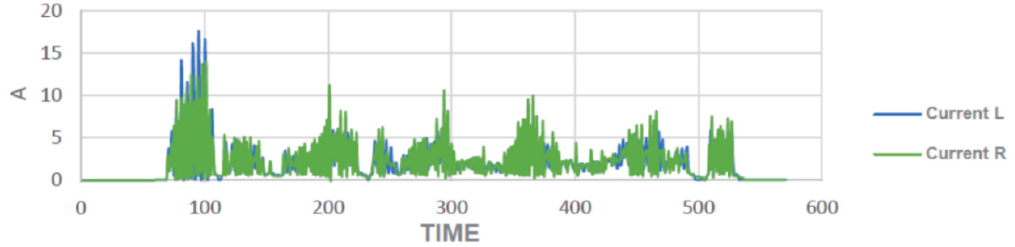
a sloping circuit.